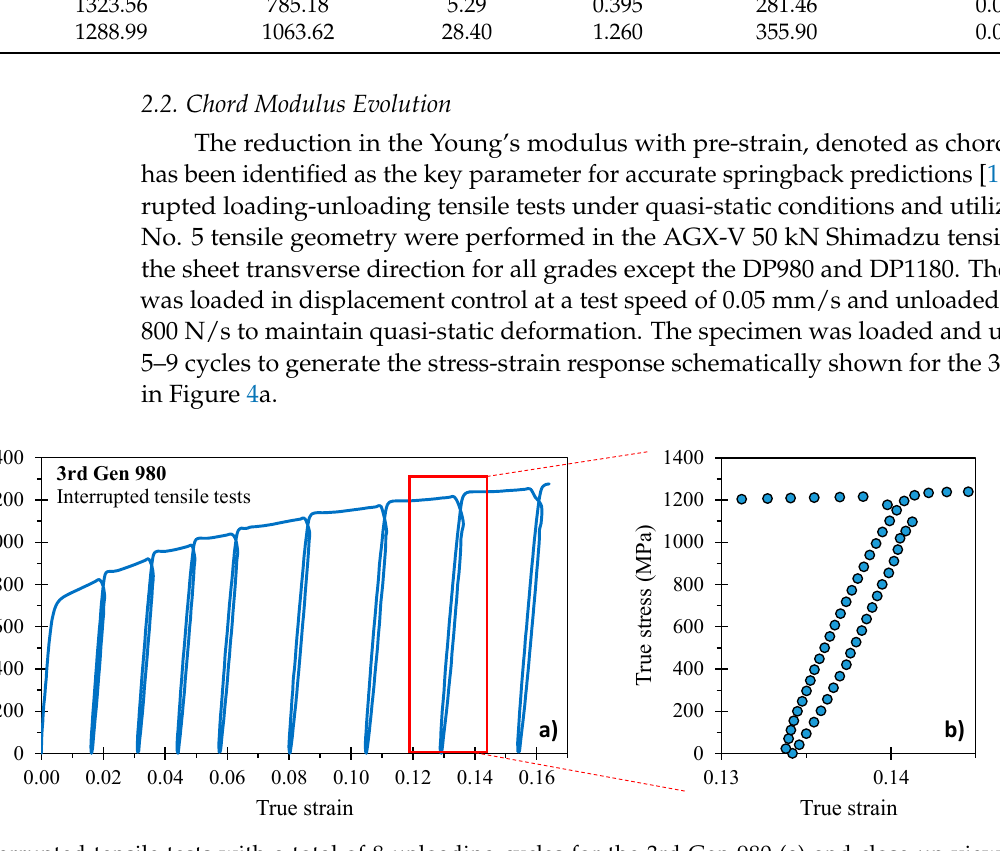
Figure 4. Interrupted tensile tests with a total of 8 unloading cycles for the 3rd Gen 980 ( a ) and close-up view of the non-linear unloading behavior, schematically shown for the seventh unloading cycle ( b ).